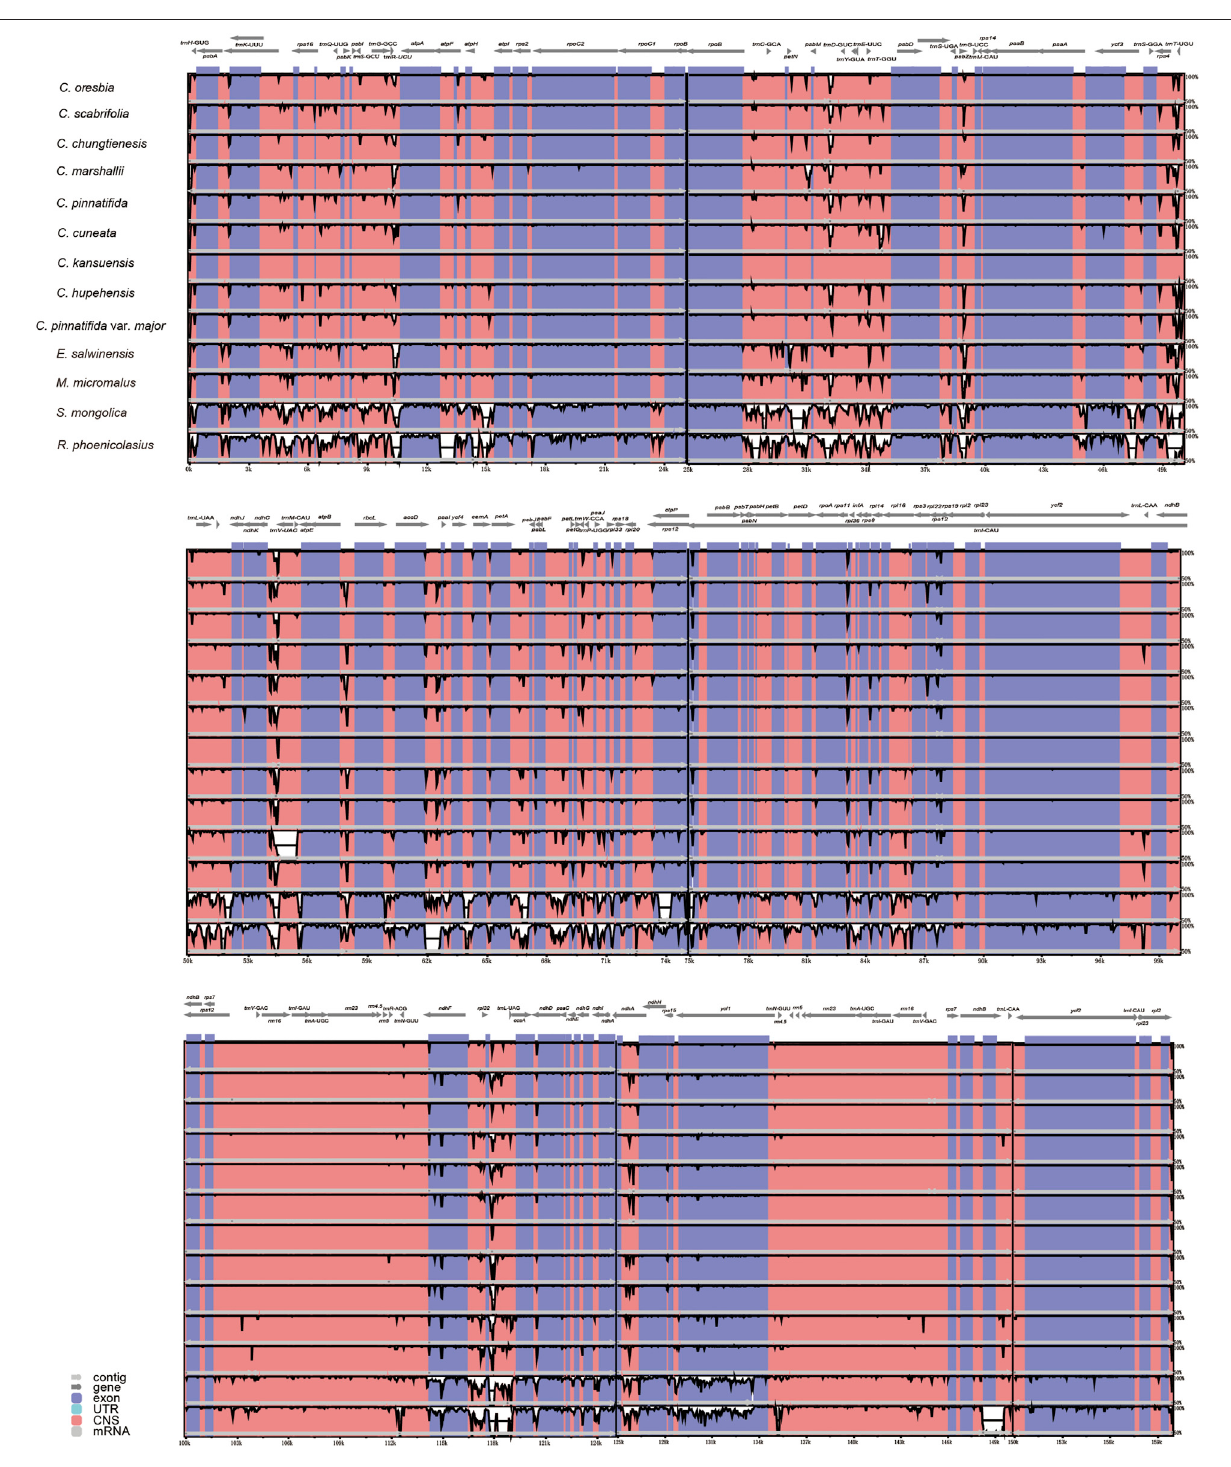
Frontiers in Genetics |